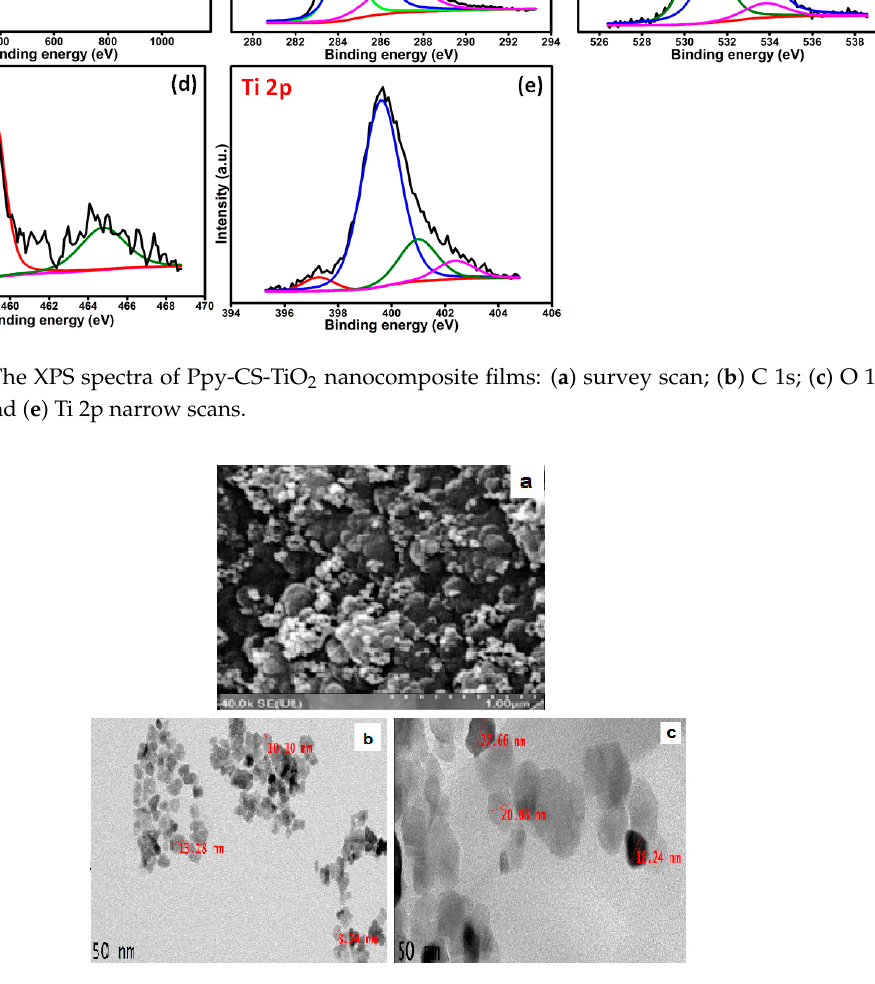
Figure 2. ( a ) FE-SEM micrograph of Ppy-CS-TiO 2 ; ( b ) HR-TEM image of TiO 2 ; ( c ) HR-TEM image Ppy-CS-TiO 2 nanocomposite films.